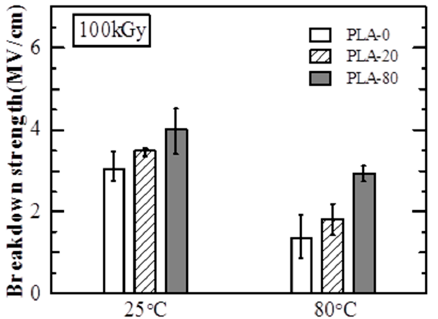
Figure 6. Breakdown strength ( E B ) of irradiated samples (100 kGy).